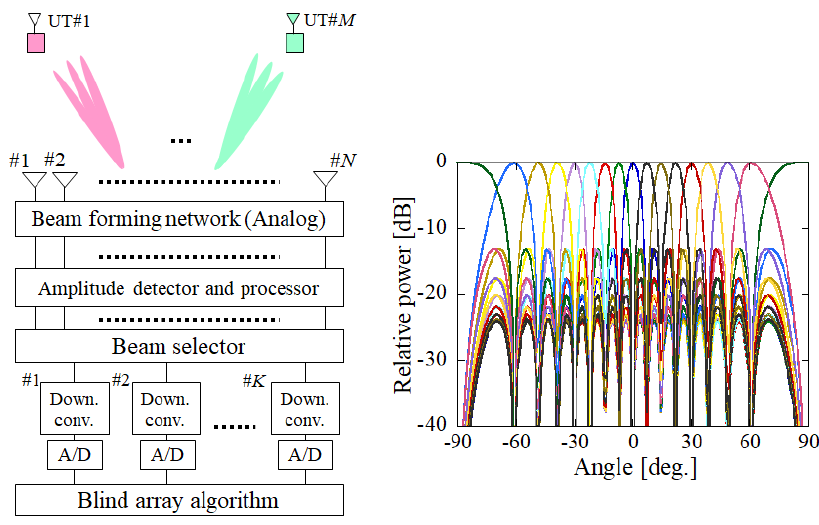
Figure 2. Uplink configuration of multi-beam massive MIMO in uplink and 16 multi-beam